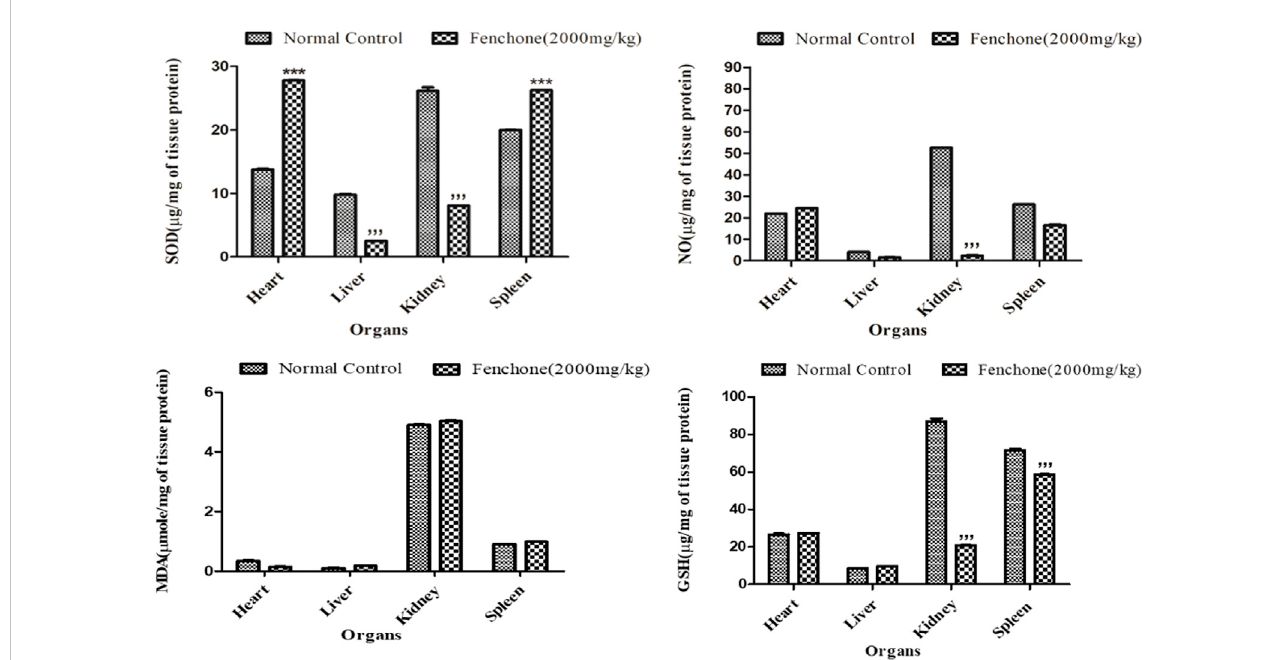
FIGURE 1 Oxidative stress marker analysis in treated animals in the acute toxicity study. Data are stated as mean ± SEM, N = 3. *** p < .001 represents a signi fi cant increase, while ’’’ p < .001 represents a signi fi cant decrease vs. normal control.